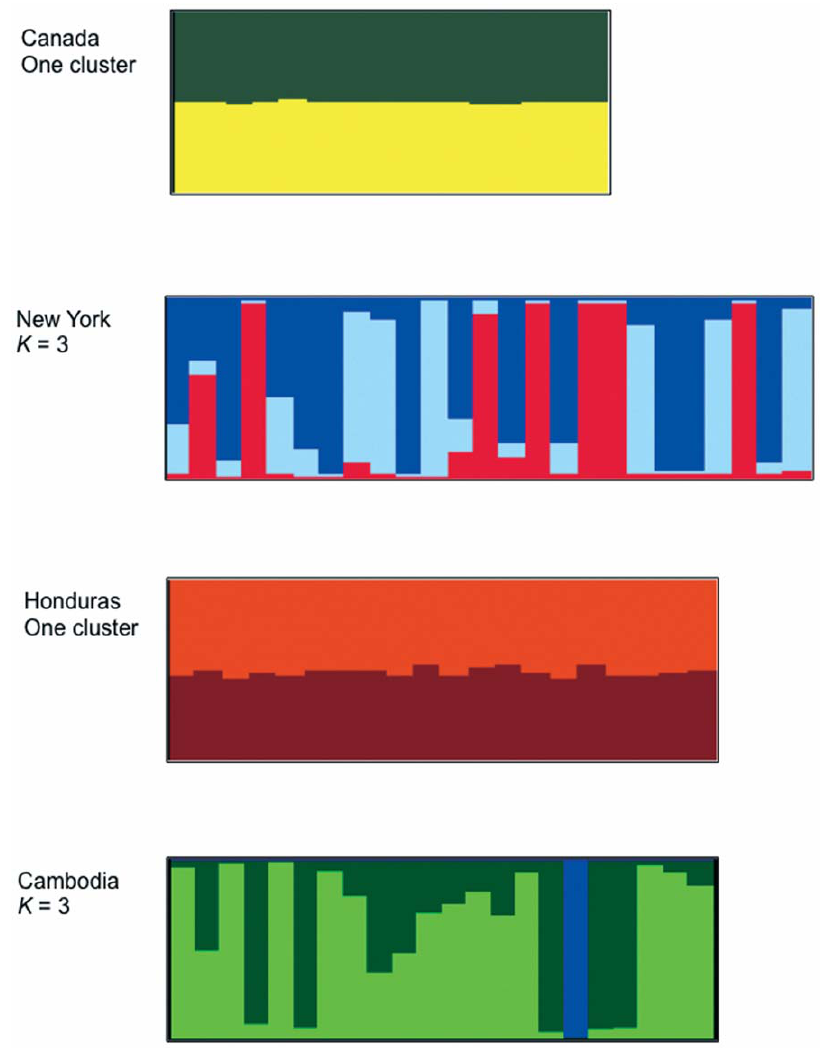
Figure 5. STRUCTURE results for each geographic site with 10 or more lice: Canada, New York, Honduras and Cambodia (based on average membership coefficient, Q , derived from 14 microsatellite loci). doi:10.1371/journal.pone.0057619.g005 clothing and head louse populations are needed to discern the role of these factors in shaping the genetic structure and diversity of human lice.